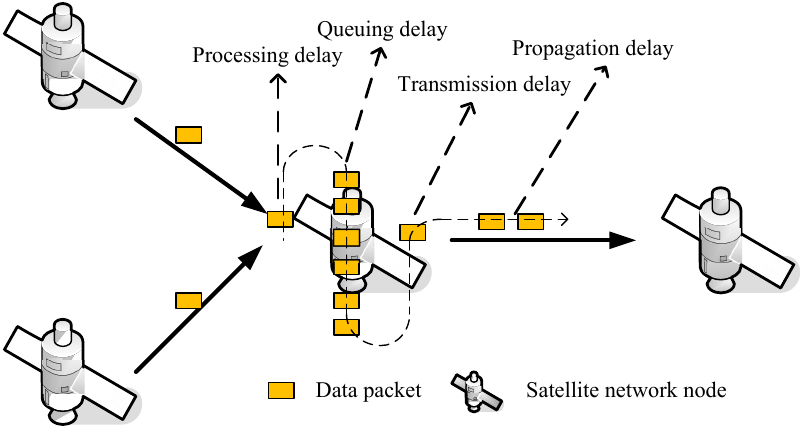
Figure 5. All kinds of delay in a satellite